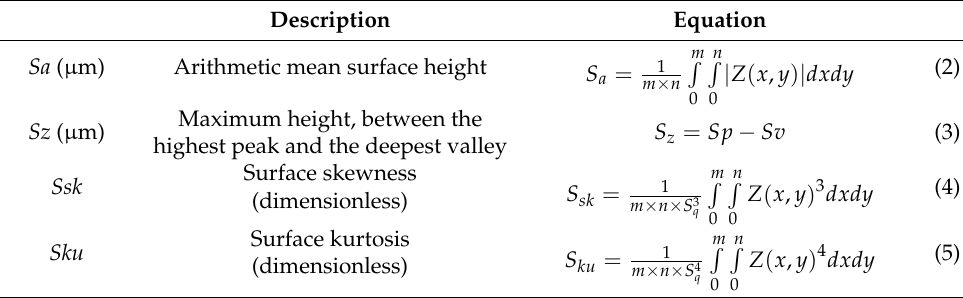
Figure 5. ( a ) Samples E ( α = 90°) and samples F1, F2, and F3, ( b ) sample F4, ( c ) position of 3D surface measurements.